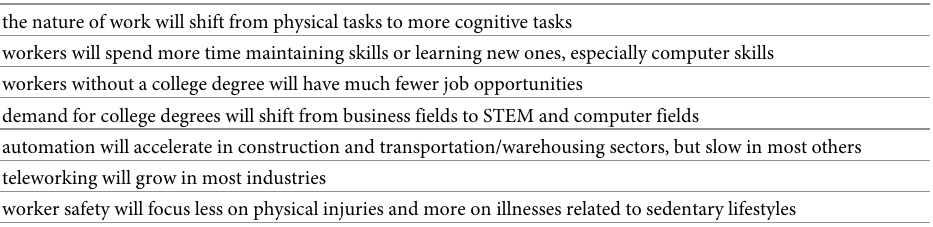
Table 14. Summary of key long-term COVID impacts on future